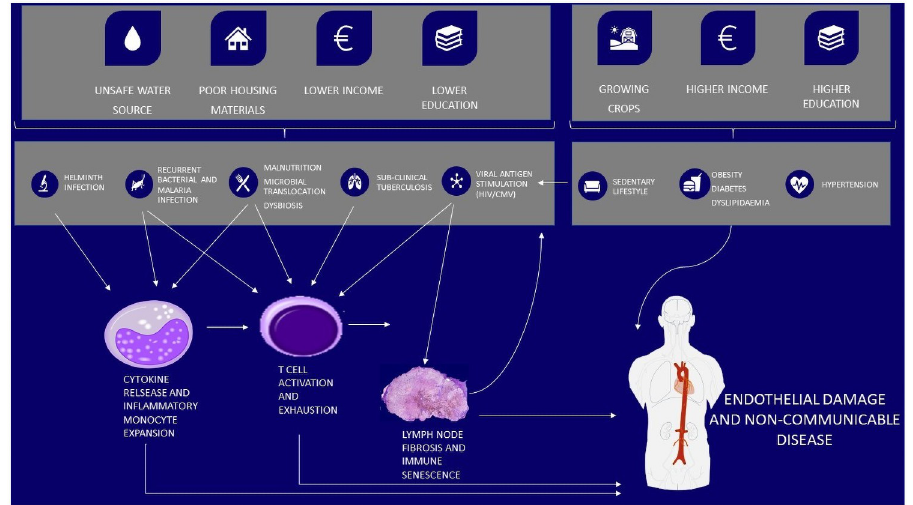
Fig 4. Hypothesis for the role of socio-economic determinants in chronic inflammation and endothelial damage amongst PLWH in low income SSA. Hypothesis for the impact of socio-economic factors on inflammation mediated non-communicable diseases in people living with HIV in low-income settings. This builds on previously documented relationships between drivers of inflammation, and its effect on endothelial damage in this setting [4, 5]. Further research will be required to evaluate and improve our understanding of the factors driving immune activation and non-communicable disease in low-income settings.